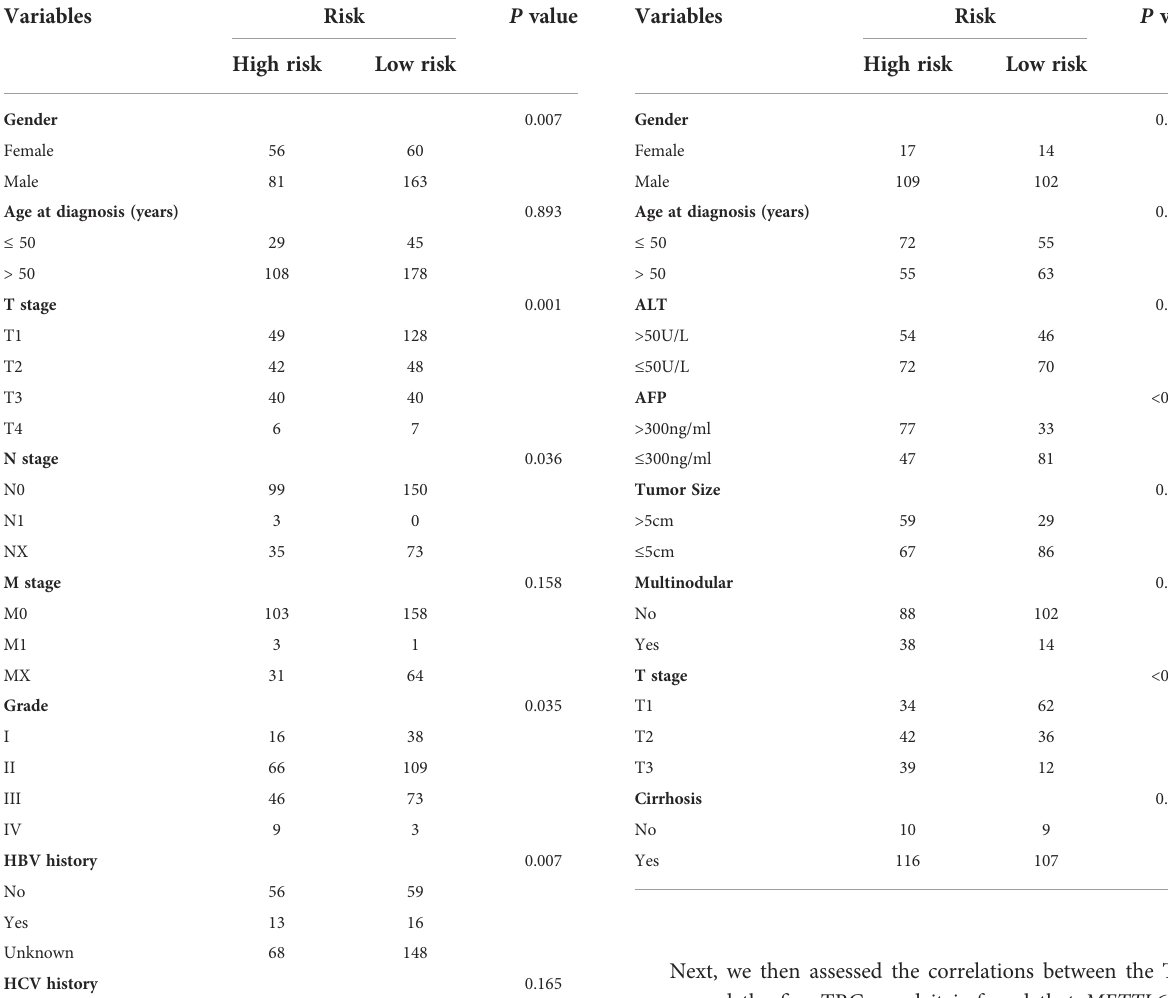
TABLE 2 Clinicopathologic characteristics of GSE14520 HCC patients according to the Tyrosine -related